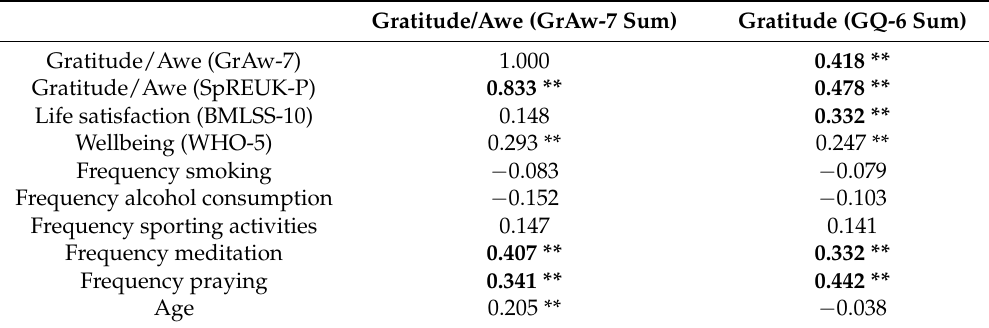
Table 3. Correlations between gratitude, wellbeing, and health behavior. Gratitude/Awe (GrAw-7